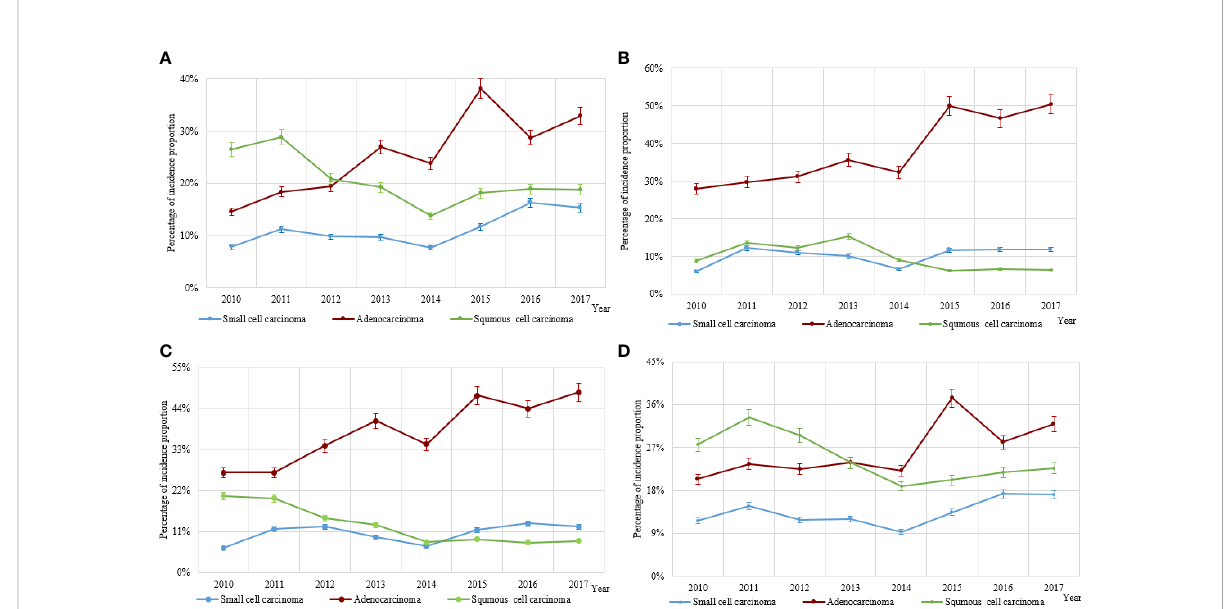
FIGURE 2 The incidence distribution of the three main histological types of lung cancer (lung adenocarcinoma, squamous cell carcinoma, and small cell carcinoma). (A) The incidence distribution of the three main histological types of lung cancer in men. (B) The incidence distribution of